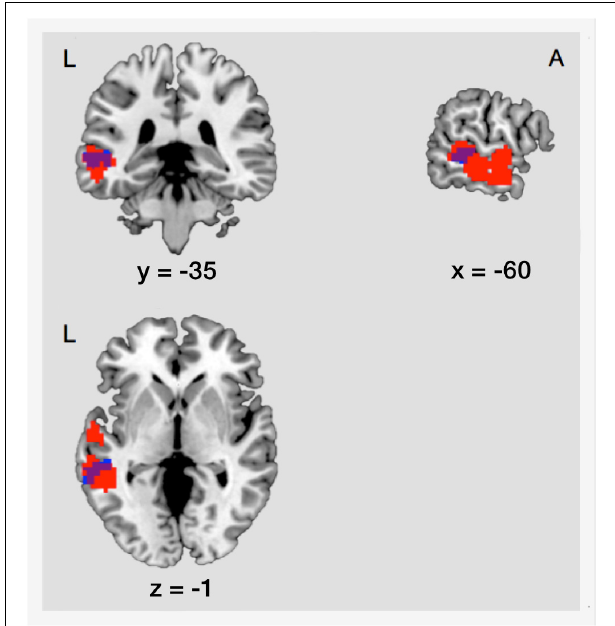
FIGURE 6 | Structural overlap of regions involved in consolidation and those involved in retrieval. Blue, cluster showing increased functional connectivity between the right IOG/fusiform gyrus and the left MTG during consolidation. Red, cluster showing main effect of memory during retrieval in the left MTG. The overlap covers an area of 53 voxels. L, left; A, anterior; IOG, inferior occipital gyrus/fusiform gyrus; MTG, middle temporal gyrus.